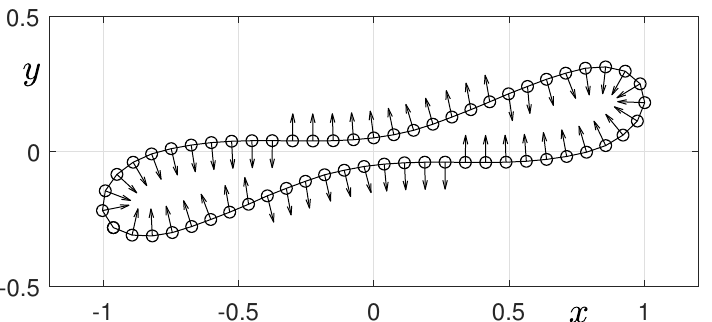
Figure 6. Schematic illustration of the surface tension force in two-dimensional space.